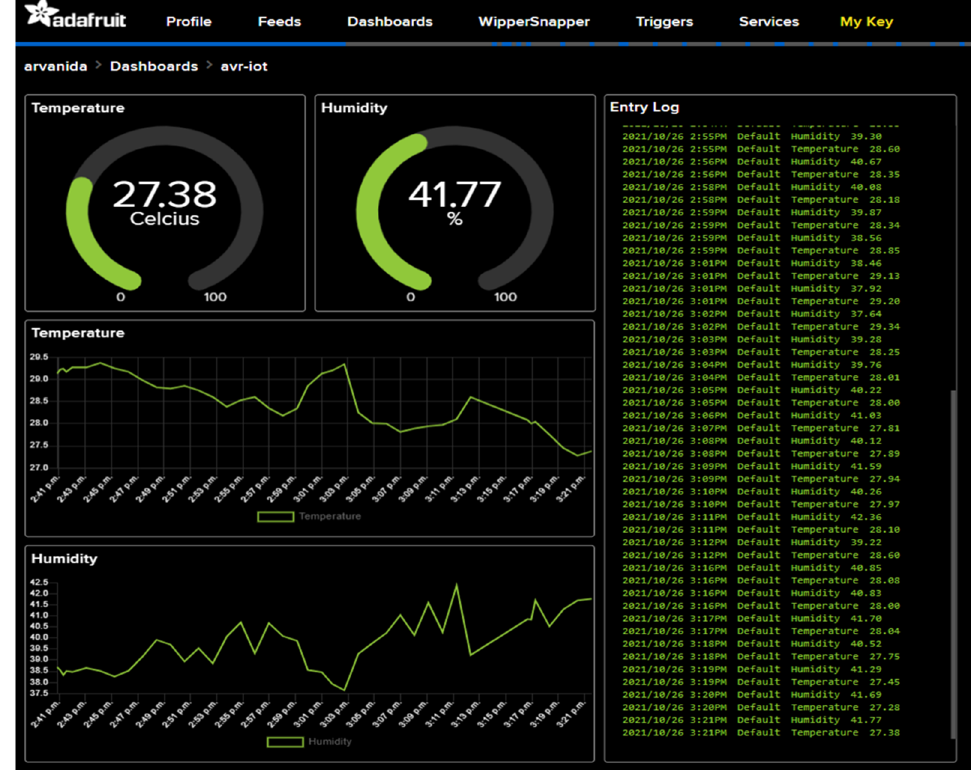
Figure 18. Dashboard monitoring.